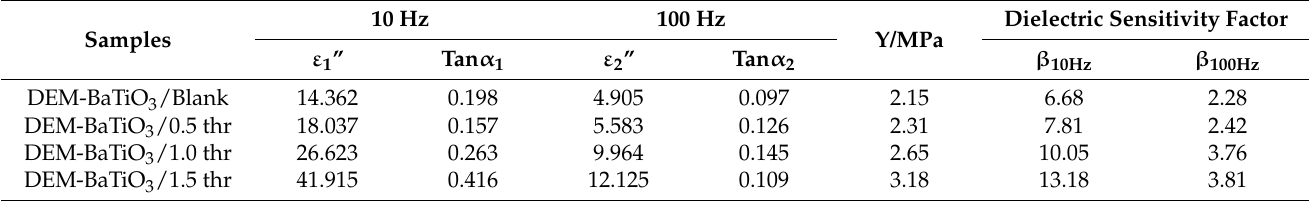
Table 4. Dielectric properties and dielectric sensitivity factors of MDI-polyurethane composite fiber